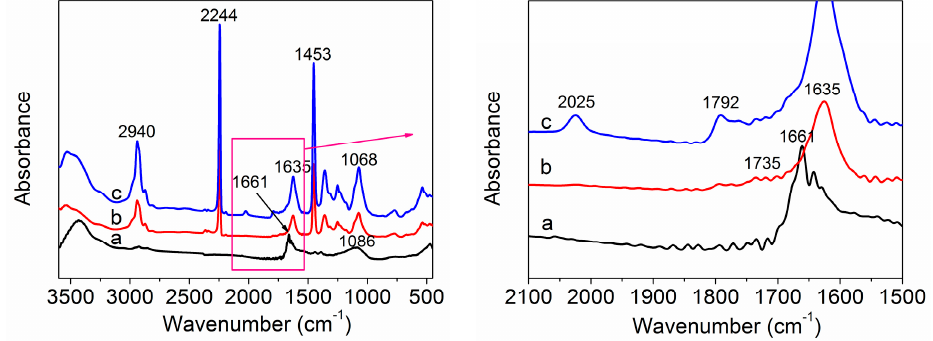
Figure 3. Fourier transform infrared (FTIR) spectra of ( a ) amino-CNTs, ( b ) PAN homopolymer and ( c ) amino-CNT/PAN microspheres.